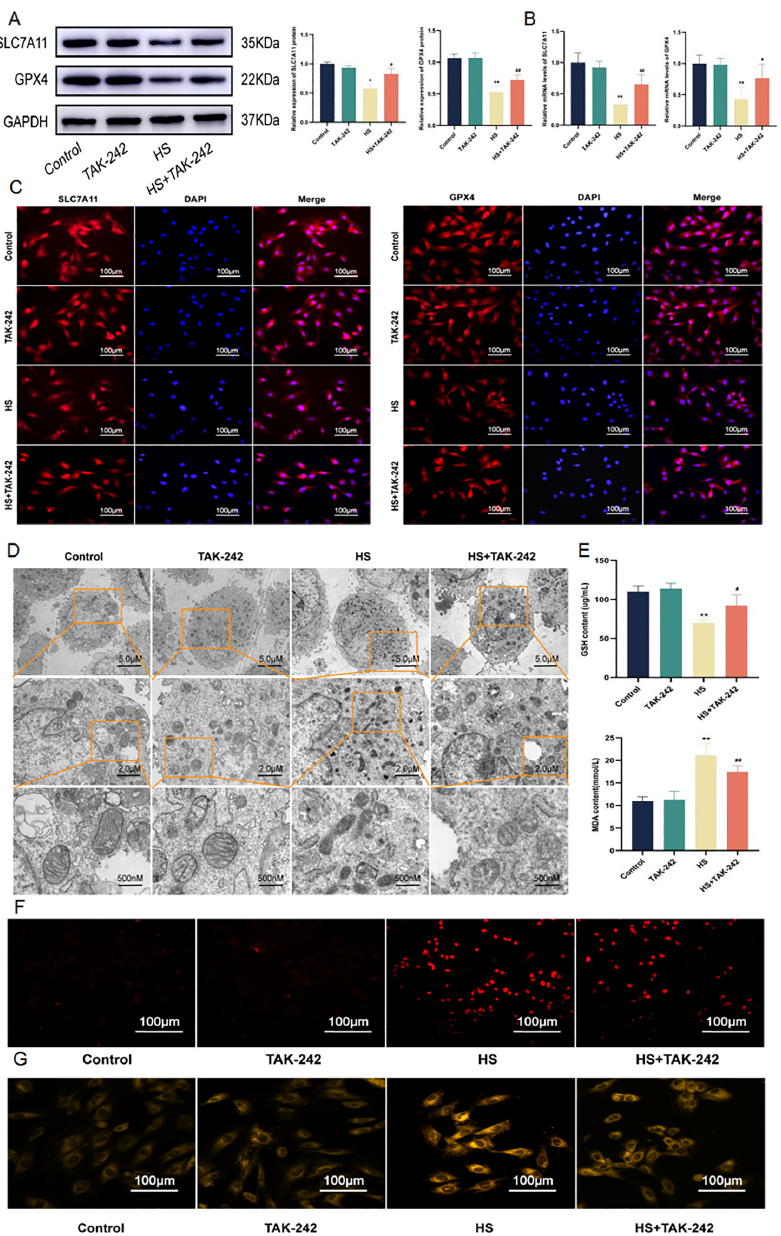
Figure 6. TAK-242 improved HS-induced ferroptosis. The protein levels of SLC7A11 and GPX4 in H9C2 cells were determined using Western blotting ( A ). The mRNA levels of SLC7A11 and GPX4 in H9C2 cells were determined using RT-qPCR ( B ). Fluorescence images of H9C2 cells stained with DAPI, anti-GPX4 antibody, and anti-SLC7A11 antibody. Scale bars = 100 µ m ( C ). Image of mitochondrial structure of H9C2 cells at 1200 × , 2000 × , or 10,000 × magnification. Scale bars = 5 µ m, 2 µ m and 500 nm ( D ). GSH and MDA levels in H9C2 cells ( E ). ROS level in H9C2 cells. Scale bars = 100 µ m ( F ). Fe 2+ level in H9C2 cells. Scale bars = 100 µ m ( G ). The results were expressed as the mean ± SD deviation of three independent experiments. * p < 0.05, ** p < 0.01 vs. the control group; # p < 0.05, ## p < 0.01 vs. the HS